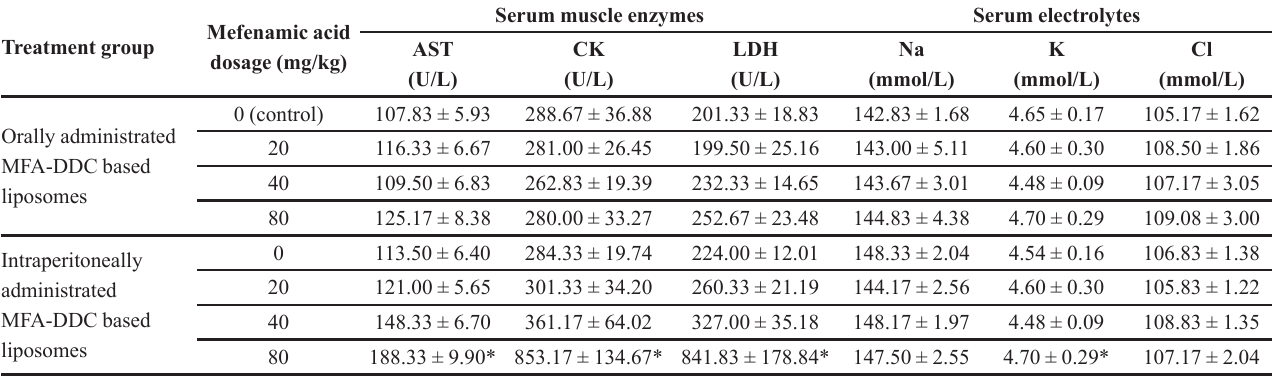
TABLE V - Biochemical alterations demonstrated by rats exposed to oral or intraperitoneal MFA-DDC liposomes